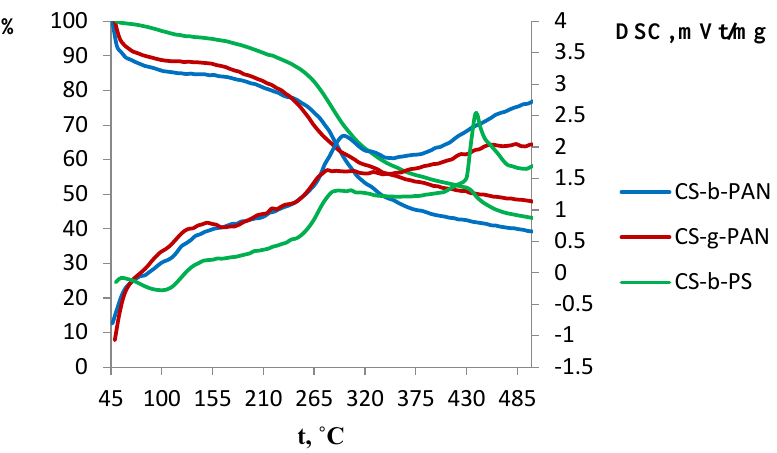
Figure 8. DSC and TGA curves of CS-g-PAN, CS-b-PAN, and CS-b-PS copolymers.